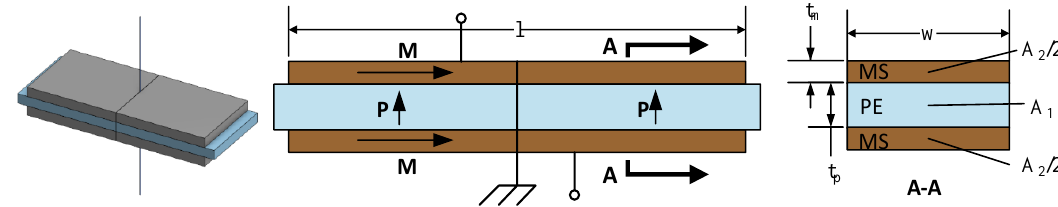
Figure 2. Geometry layout for L-T mode bimorph. Arrows M and P show the magnetization and polarization orientation. Adapted from [13].